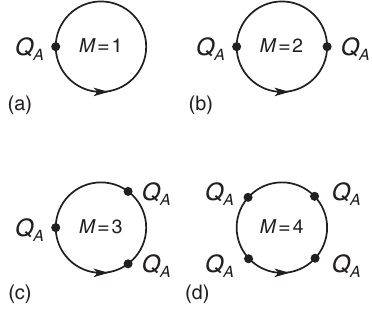
FIG. 3. (a) – (d) Feynman diagrams for the connected correlation functions h Q M for M ¼ 1 ; 2 ; 3 ; 4 generated by the cumulant i c A expansion Eq. (2.12). Solid lines are free-fermion propagators, and small circles are Q A